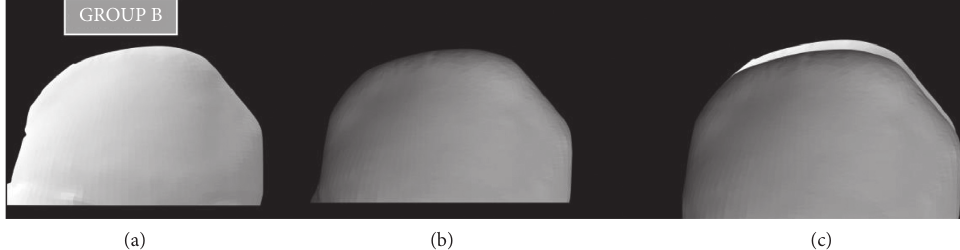
Figure 3: (a) 3D prescan of primary teeth with Group B, (b) 3D postscan of primary teeth with Group B, and (c) superimpose of prescan and postscan with Group B.